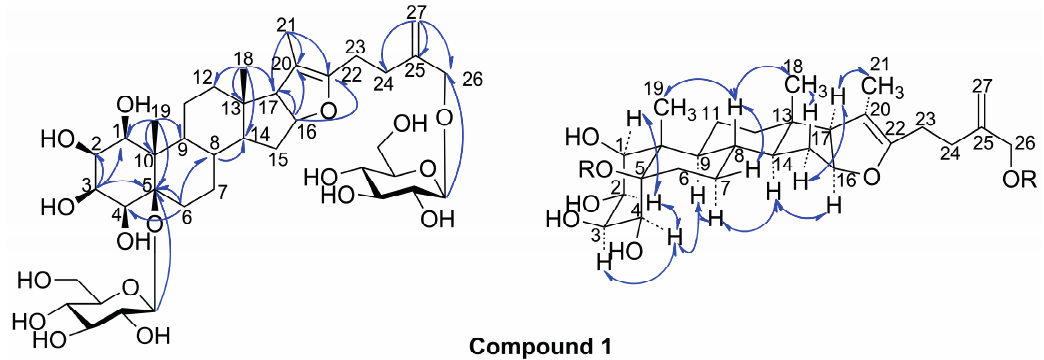
Figure 2. Key HMBC and NOESY correlations of the compound 1